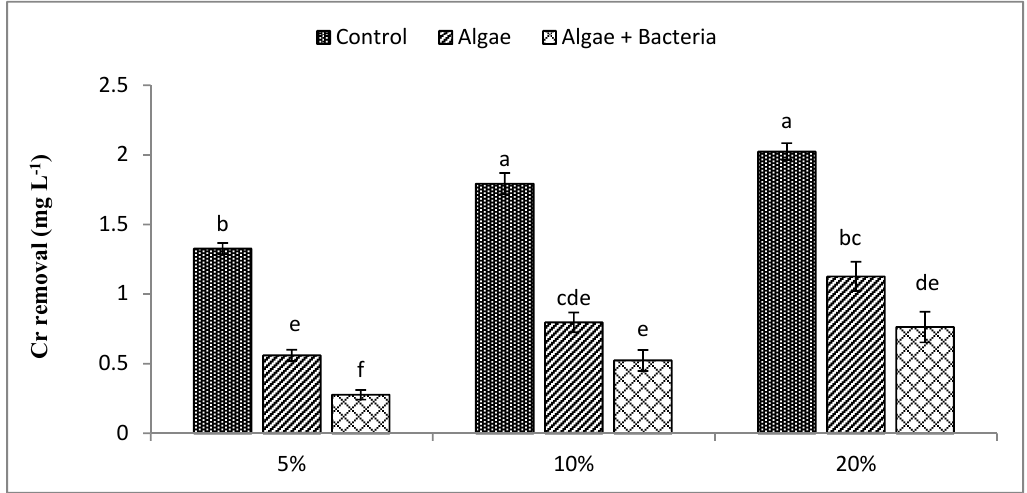
Figure 3. Efficiency of algae and algal–bacterial consortium for chromium removal from textile industry wastewater. Column shows mean values, and bars shows standard deviations (SD) of means. All means followed by different letters were significantly different according to Tukey HSD test at p < 0.05.